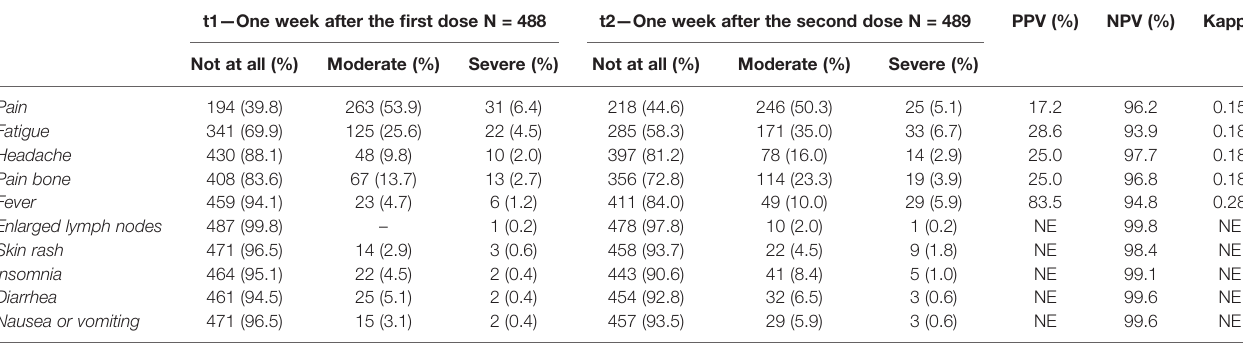
TABLE 2 | Occurrence of symptoms/adverse events over the week after vaccine administration. t1 — One week after the fi rst dose N = 488 t2 — One week after the second dose N =